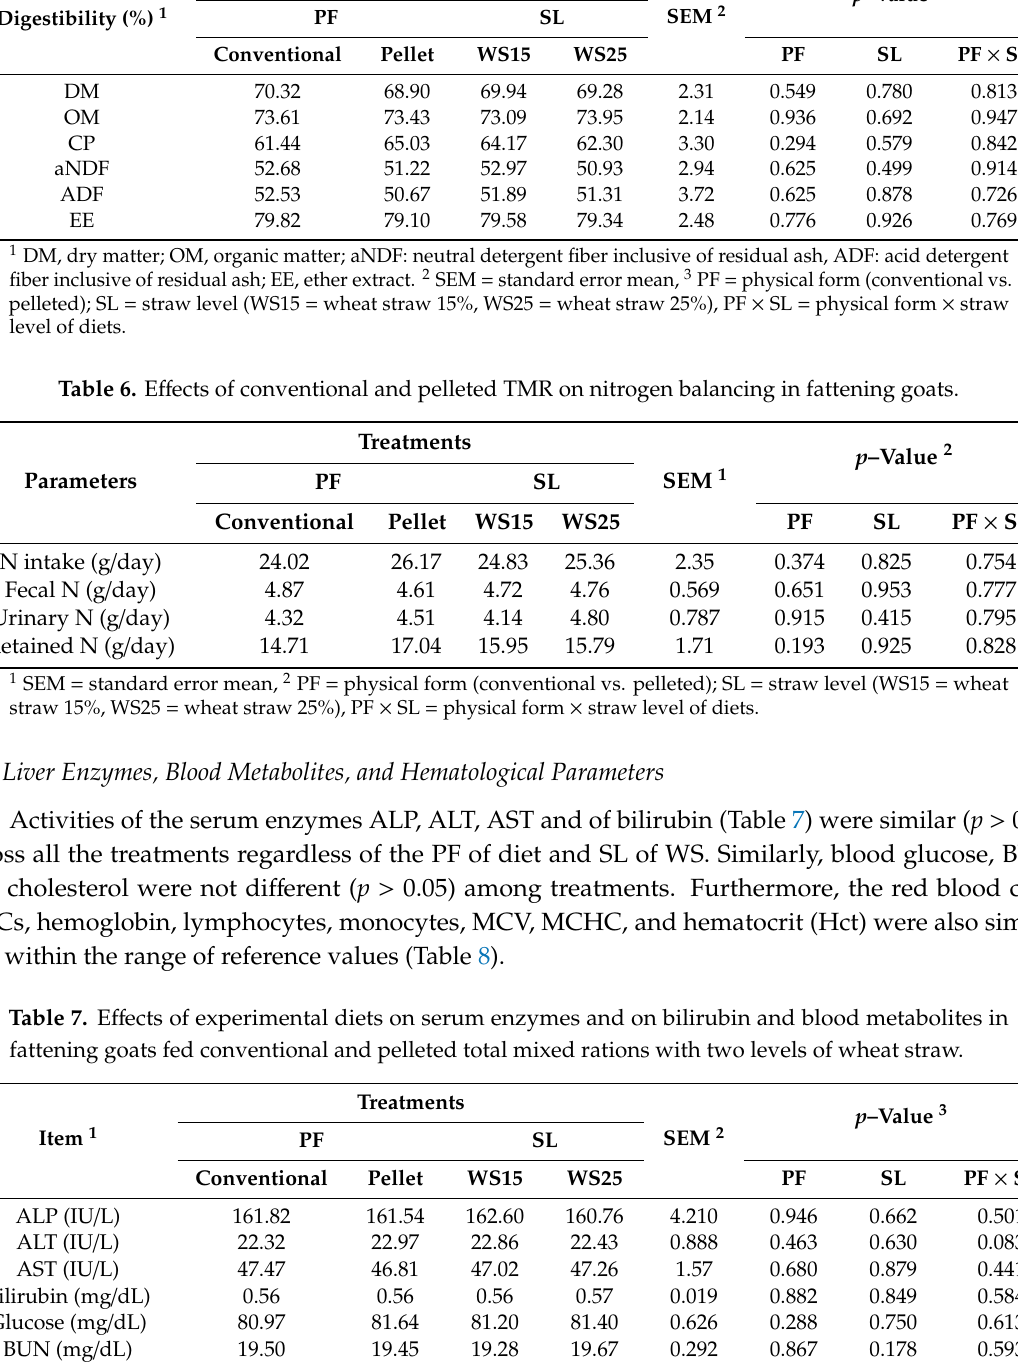
Digestibility (%) 1